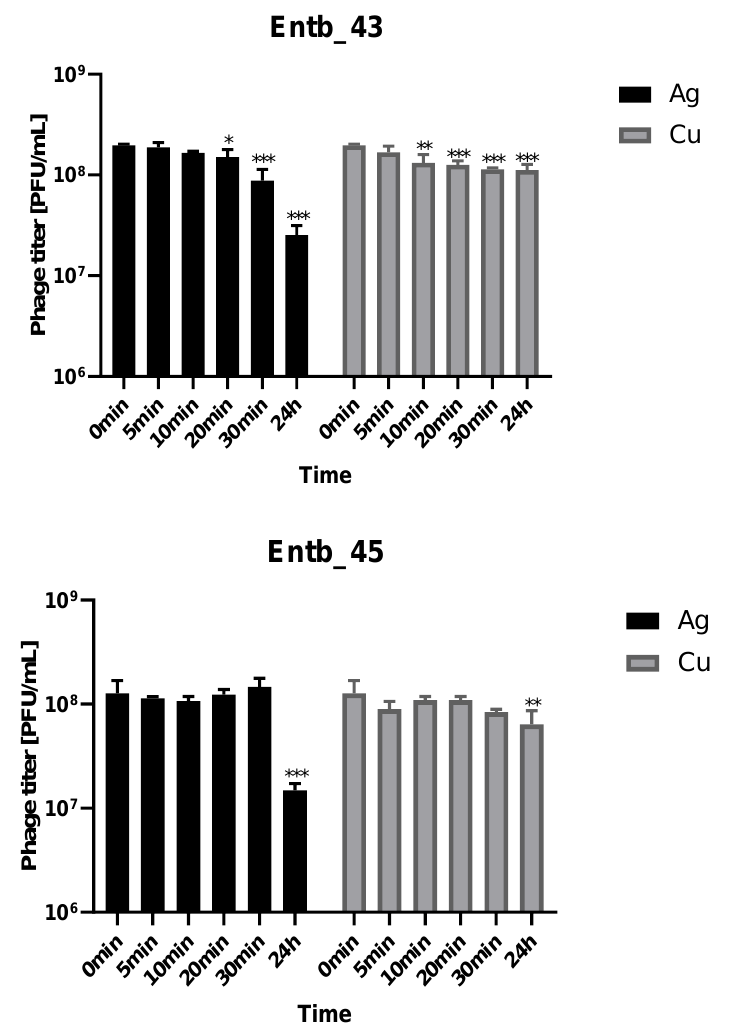
Figure 8. Phage lysate stability in silver nanoparticles and copper nanoparticles. Samples at the start of the experiments (0 min) were treated as controls for statistical analysis. Error bars represent the standard deviation (±SD) of the mean phage titers. * p < 0.05; ** p < 0.01; *** p < 0.001.